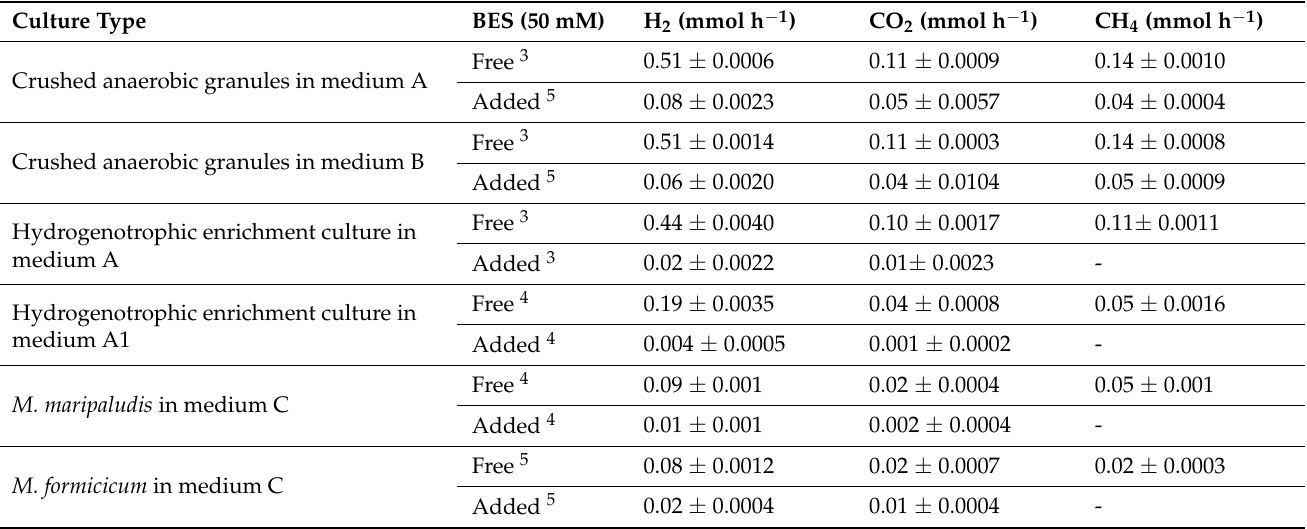
Figure 1. The gas phase for the inhibited and non-inhibited anaerobic granules in batch cultures with medium A and B. The bottles were pressurized solely with H 2 (80%) and CO 2 at ~2.2 bar during one batch cycle. All experiments were conducted in 200-mL serum bottles with 50 mL working volume. The error bars depict the standard deviation of the mean of n = 3 for non-inhibited cultures and n = 5 for inhibited cultures. When not visible the error bars are smaller than the symbol. Open symbols of panel ( a ) show non-inhibited cultures and filled symbols of panel ( b ) show BES-amended cultures with the following description: solid line (medium A), dashed line (medium B), circle (H 2 ), square (CO 2 ), and triangle (CH 4 ). Table 2. Gas consumption (H 2 , CO 2 ) and CH 4 production rates under different experimental